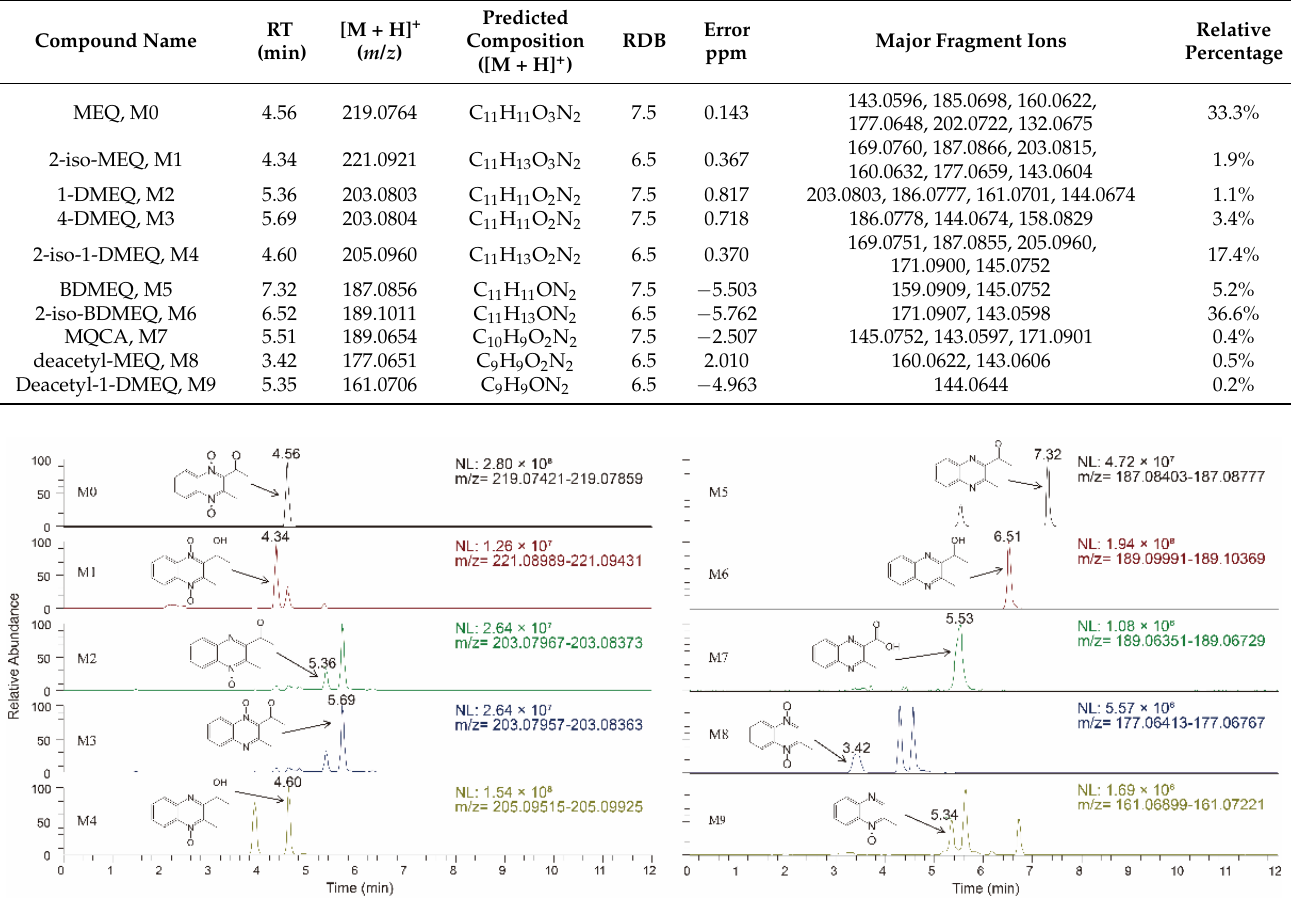
Figure 2. Accurate extracted ion chromatograms (EICs) of mequindox and its major metabolites in sea cucumber in vivo.